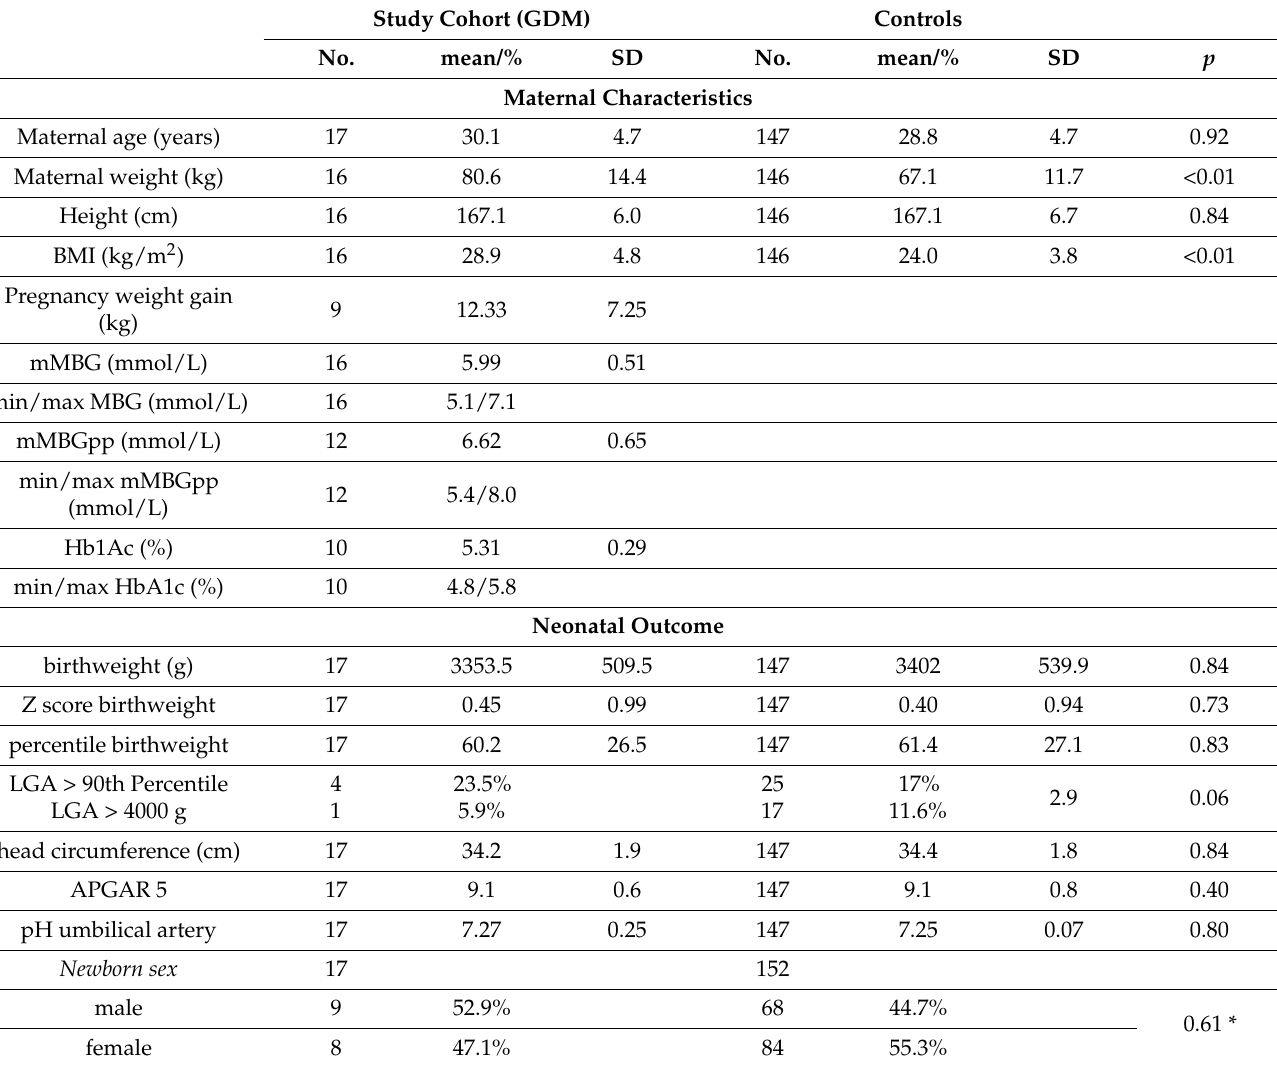
Table 2. Summary of the accompanying data of the study cohort (GDM) and comparison to the controls. Study Cohort (GDM) Controls No. mean/% SD No. mean/% SD